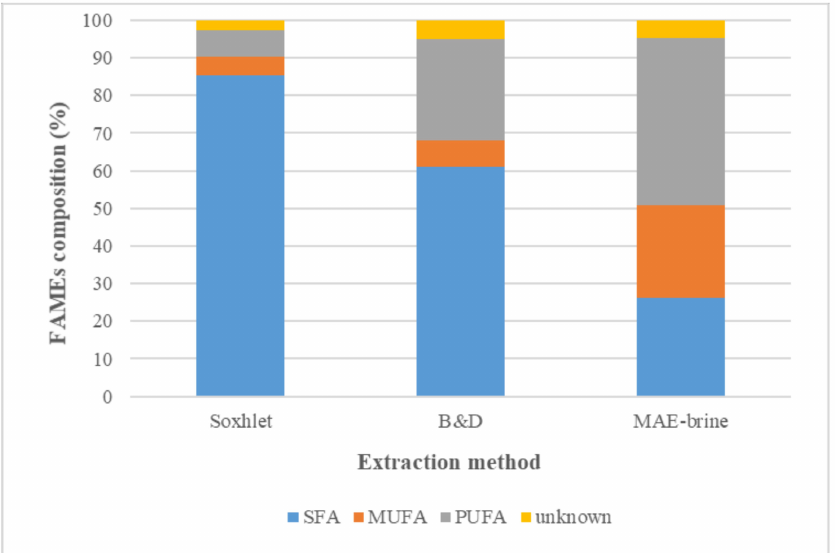
Figure 9. Comparison analysis of FAMEs distribution of Nannochloropsis sp . microalgae using di ff erent extraction methods of Soxhlet, B&D and MAE-brine at optimum extraction